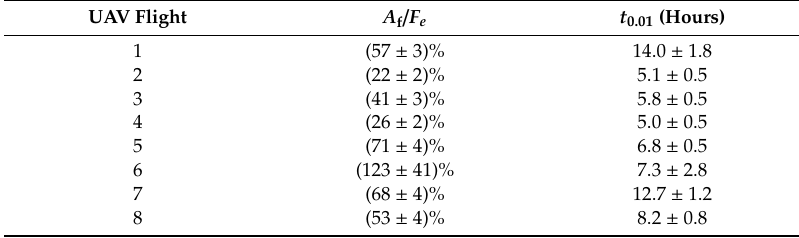
Table 1. A f as a fraction of F e and t 0.01 for each unmanned aerial vehicle (UAV) flight in the sample